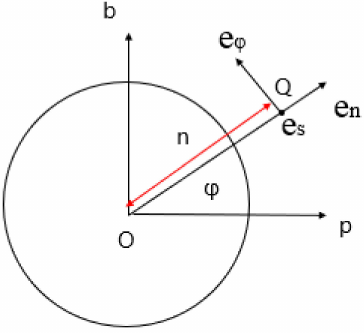
Figure 5. Polar coordinate diagram of jet